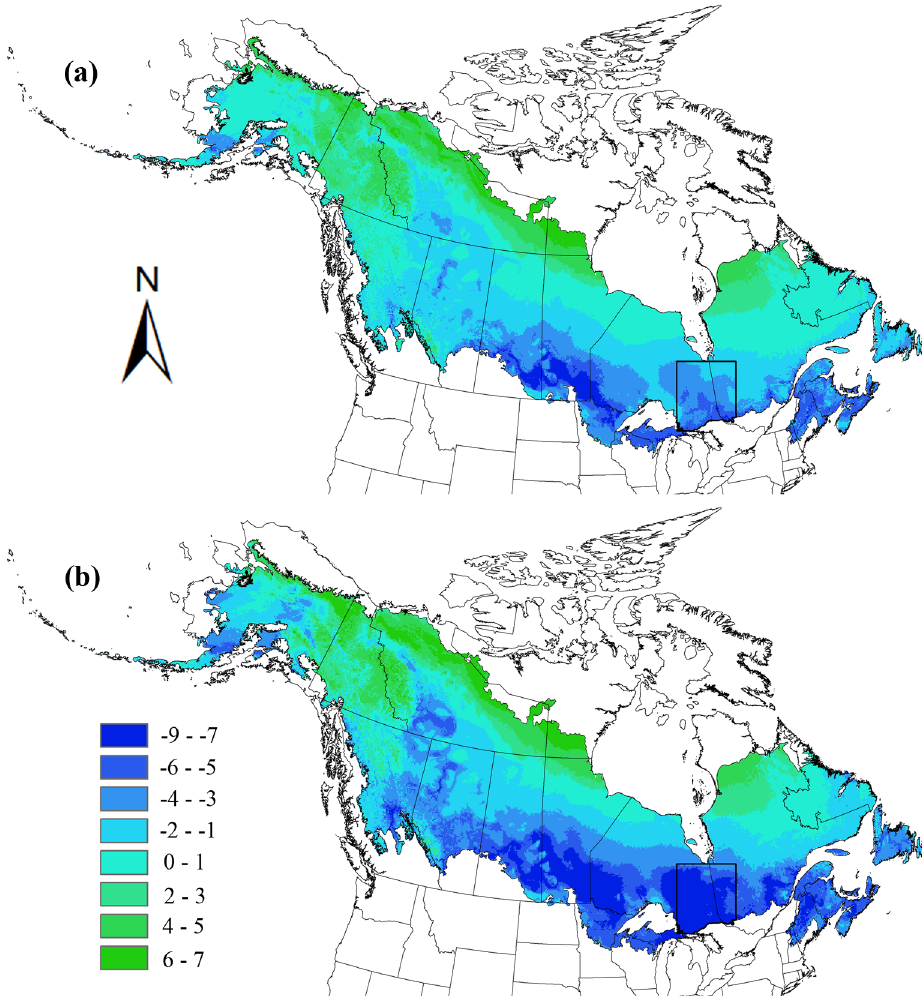
Fig 2. Predicted changein diversity of 12 boreal-obligate species in 2050 (a) and 2080 (b). Dark blue represents areas where species diversity decreased under climate changewhereaslight blue indicateszero change.Green color indicatesa positive change in diversity of the 12